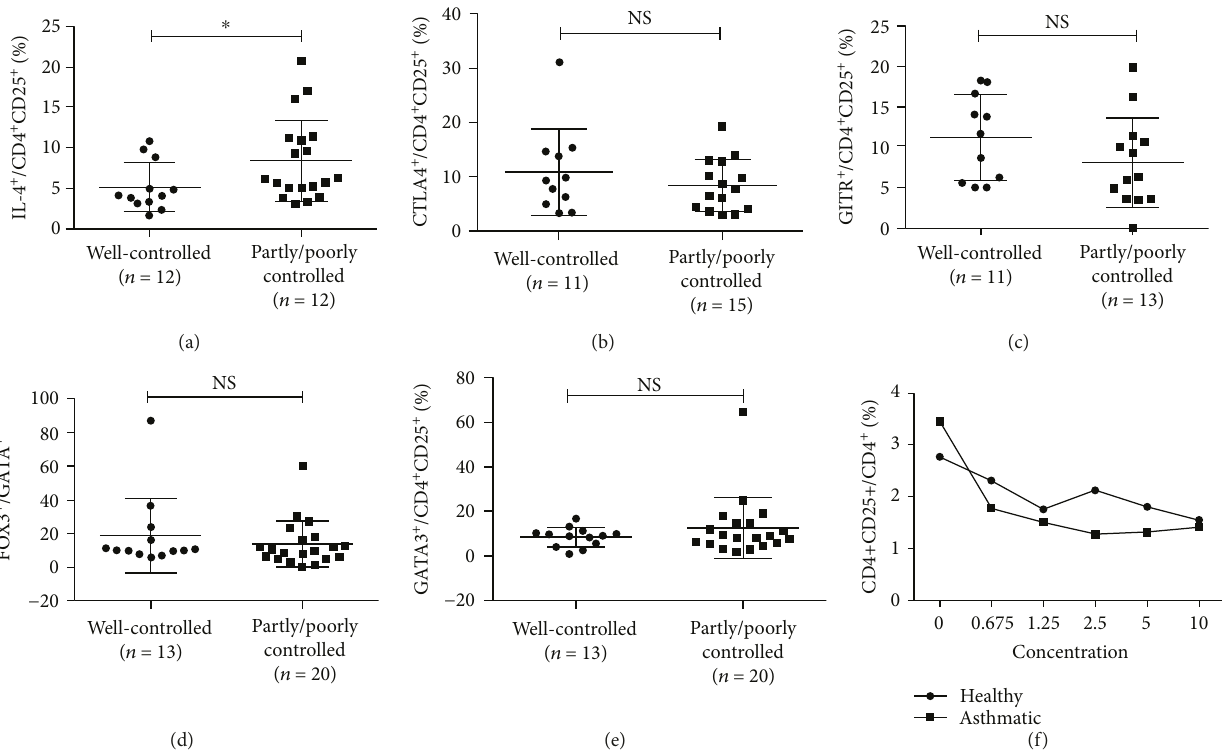
Figure 4: The expression of various markers in Treg cells in well-controlled and partly/poorly controlled groups. (a, c, d, e, f) Frequencies of IL-4, CTLA-4, GITR, FOXP3, and GATA3 expressing in well-controlled and partly/poorly controlled groups. (b) E ff ect of di ff erent IL-4 concentrations on TGF-beta induction of Treg cells from naïve T cells of healthy ( n = 8 ) and asthmatic ( n = 18 ) groups. The graph shows means ± sem . ∗ p < 0 05 . NS: no signi fi